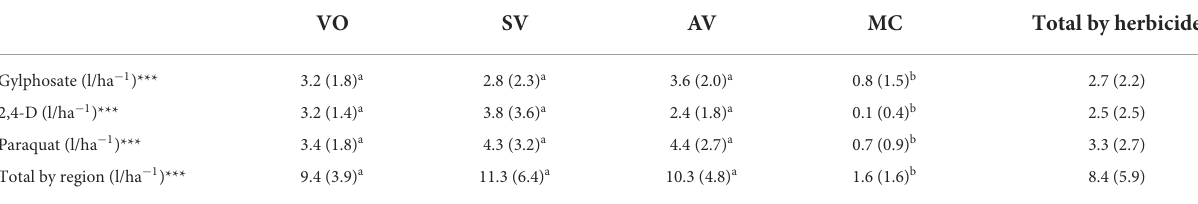
TABLE 2 Average volumes of the different herbicides per hectare in an agricultural cycle for each region. VO SV AV MC Total by